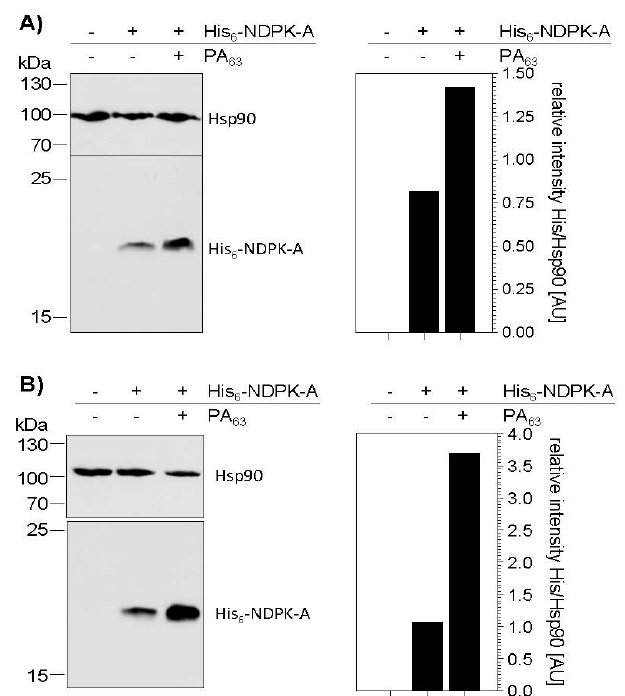
Figure 3. PA 63 mediates binding of His 6 -NDPK-A to MDA-MB-231 and HeLa cells. After adjusting MDA-MB-231 ( A ) and HeLa ( B ) cells to 4 °C they were incubated with His 6 -NDPK-A (30 µg/mL) with or without PA 63 (3 µg/mL) for 30 min on ice. After washing, the amount of His 6 -NDPK-A bound to the cells was determined by Western blotting with an anti-His-antibody. Hsp90 was detected to confirm comparable protein loading. Densitometric analysis was performed using the ImageJ software. Signal intensity of His 6 -NDPK-A was quantified against the Hsp90 signal.